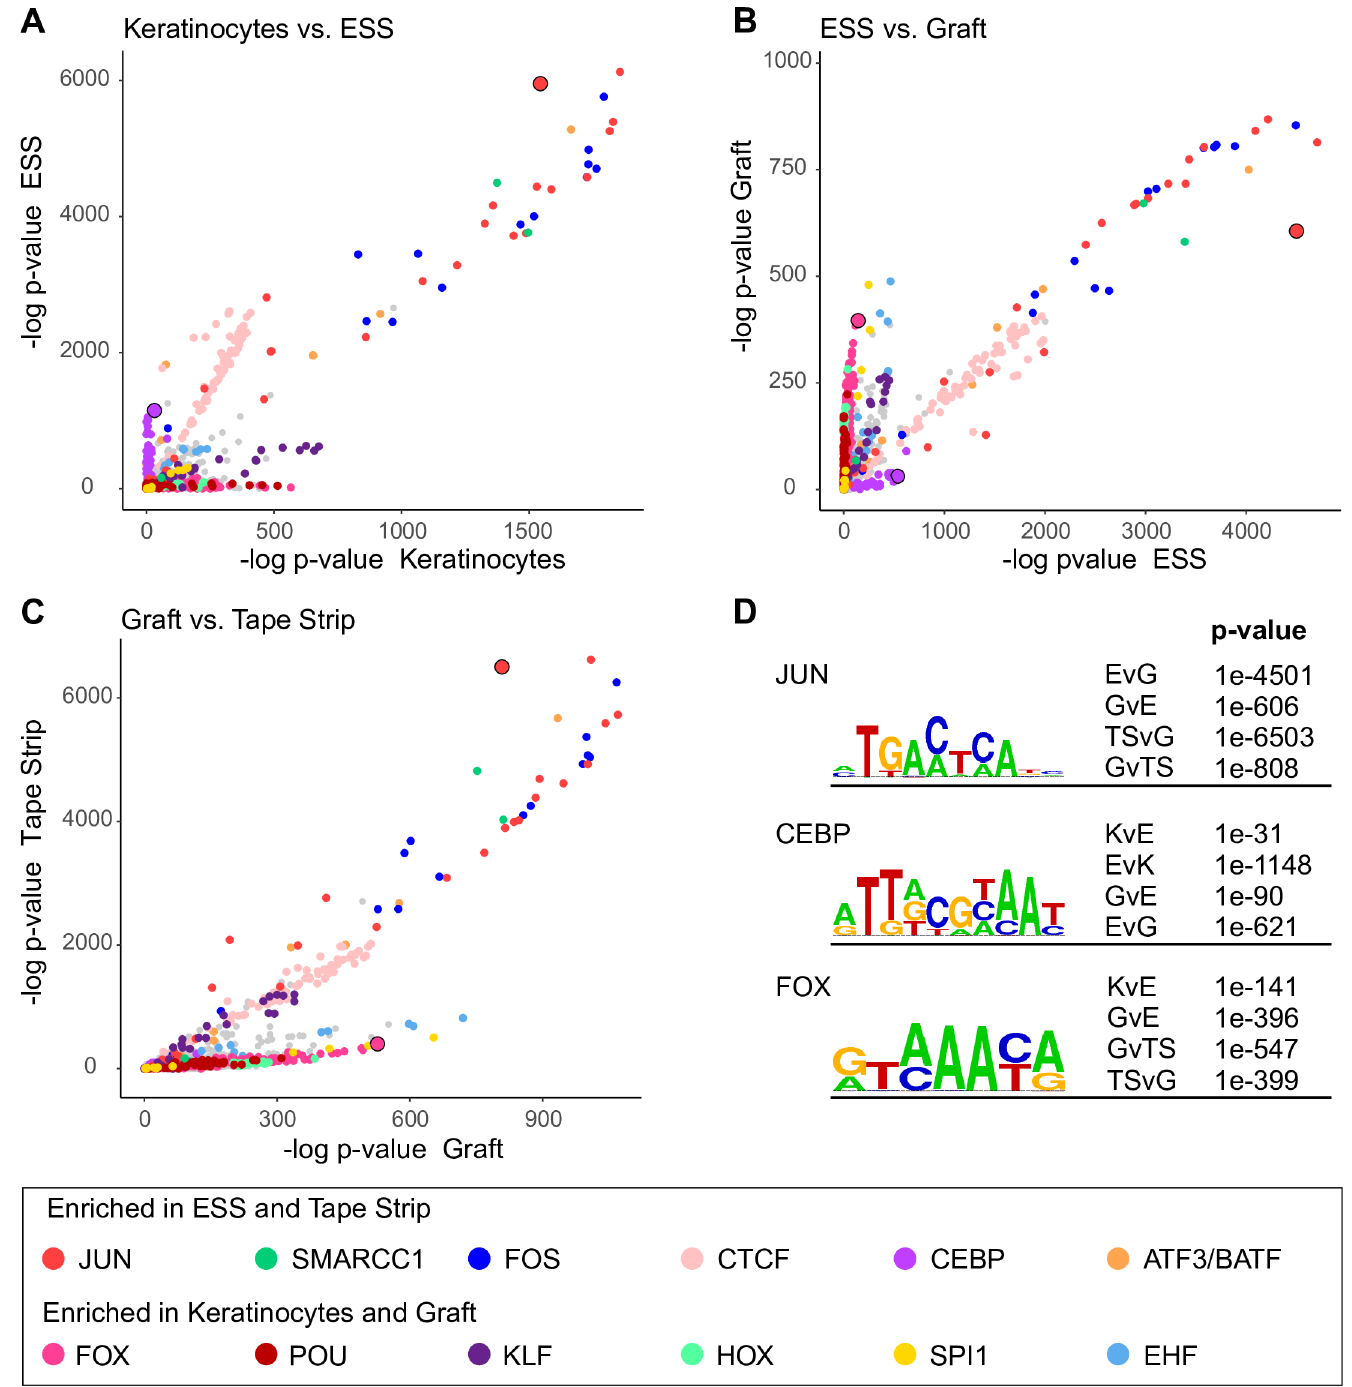
Fig 4. Transcription factor (TF) motif enrichment in chromatin associated with different stages in epidermal development or function. (A) Negativelog of the p-value of over 3000TF bindingmotifs from the Cis-BP catalogin Keratinocytes (x-axis) and ESS (y-axis). P-value indicatesmotif enrichment over a scrambled dinucleotidebackground (see text for details). Gene families with high significanceare color-codedas shown in the legend. (B) ComparisonbetweenESS and Grafted ESS and (C) Grafted ESS and Tape-strippedgraft. (D) Representative motifs identifiedin a direct comparison of enrichment betweendata sets: ESS and Keratinocytes (EvK), ESS and Graft (EvG), Tape-strip and Graft (TSvG), Keratinocytes and ESS (KvE), Graft and ESS (GvE), and Graft and Tape-strip (GvTS). Full lists of motifs and p-values can be found in S1 Appendix.